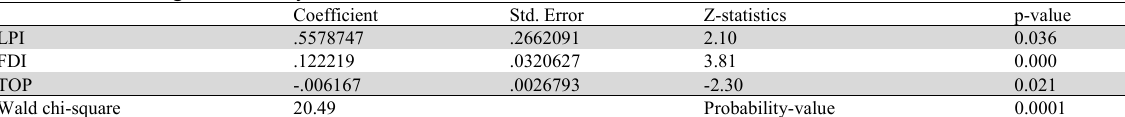
The results of the regression analysis